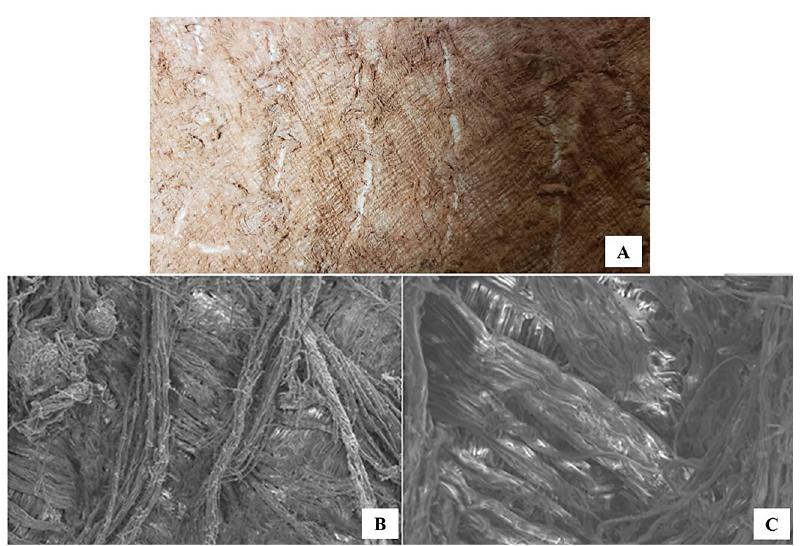
Fig 3. (A) Paiche ( A . gigas ) leather after tanning, showing the arrangement of collagen fiber bundles observed on the flesh side of the leather, (B and C) Scanning Electron Microscopy showing the arrangement and orientation of the collagen fiber bundles of the fleshy side of the paiche leather in overlapping layers.